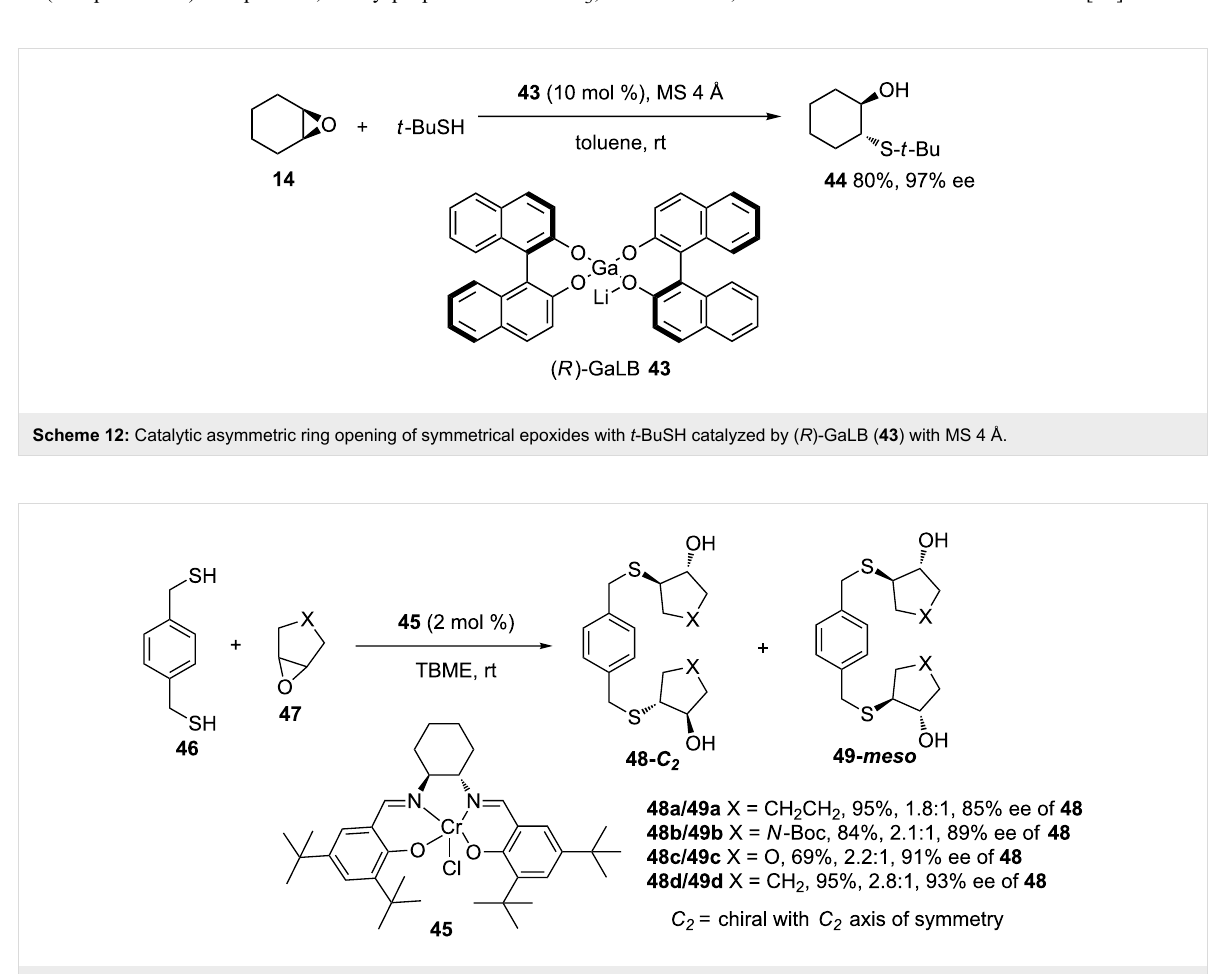
lyst whilst non-polar solvents such as cyclohexane resulted in poor enantioselectivity probably due to coordination of the product β -hydroxy sulfide. The protocol was, however, limited to unsubstituted cyclohexene oxide, and as its greatest